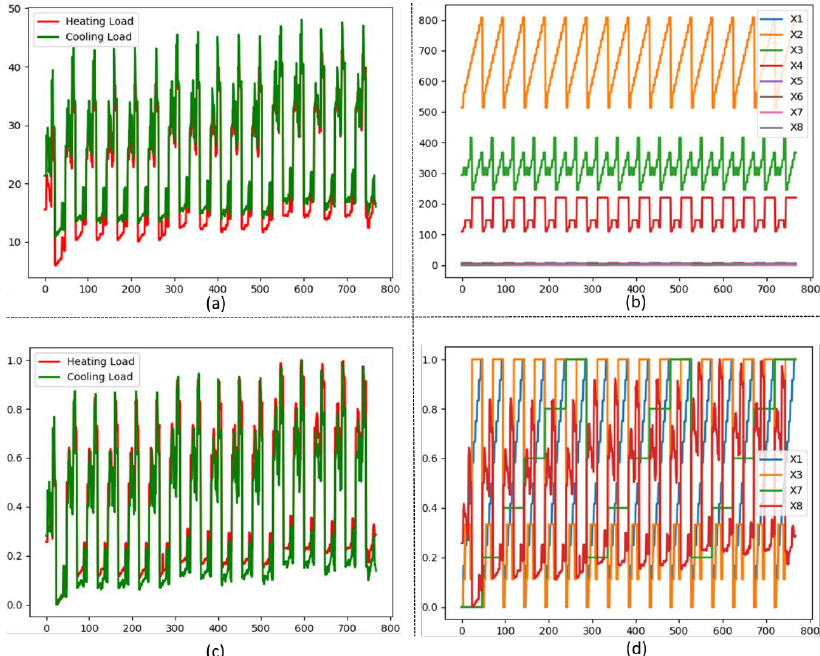
Figure 3. ( a ) Visual representation of actual HL and CL data where x -axis shows the number of samples and y -axis illustrates the range of samples; ( b ) overall attributes in the dataset; ( c ) normalized sample value of HL and CL; ( d ) normalized value of 4 attributes.